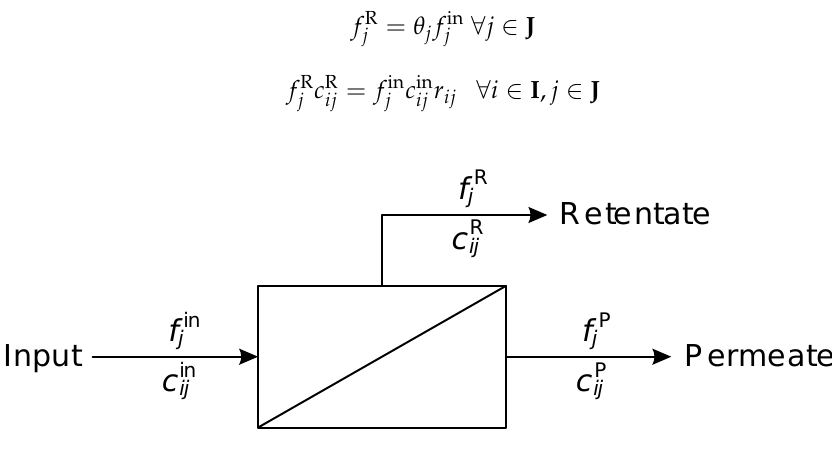
Figure 1. NF membrane unit.